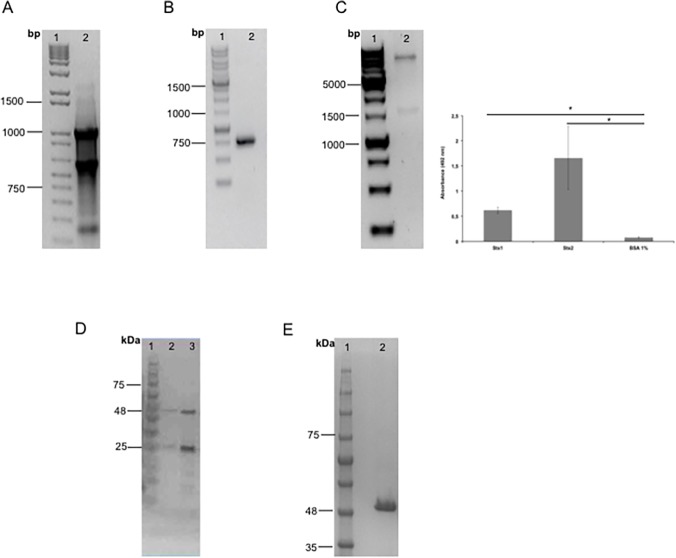
scFv and Fab purification.A. RNA extraction from Stx2 IgG-producing hybridoma. Molecular marker (lane 1); Total RNA from anti-Stx2 IgG-producing hybridoma (mAb 2E11) (lane 2). B. scFv gene cloning confirmation. Molecular marker (lane 1); PCR product (lane 2). C. scFv fragment purification. Molecular weight ladder (lane 1); scFv elutions (lanes 2 and 3). D. Phage gene cloning confirmation. Molecular marker (lane 1); Double digestion (lane 2). Phage ELISA, results of independent experiments, performed in triplicate, are expressed as the means ± SEM * p < 0.05 compared with control. E. Electrophoretic analysis of Fab fragment purification. Molecular weight ladder (lane 1); Fab fragment purified (lane 2).